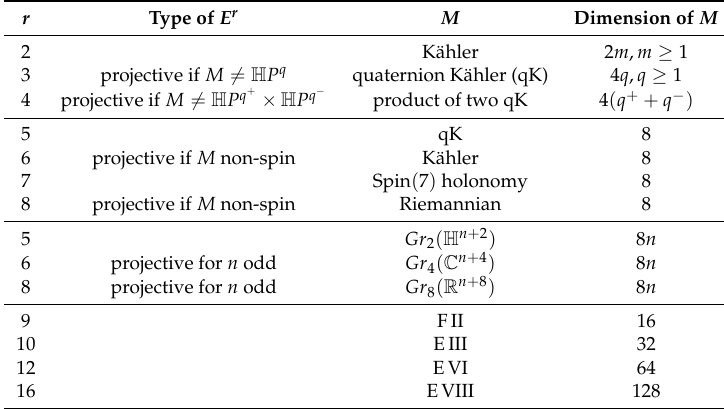
Table 4. Parallel, non-flat, even Clifford structures (cf. Ref.